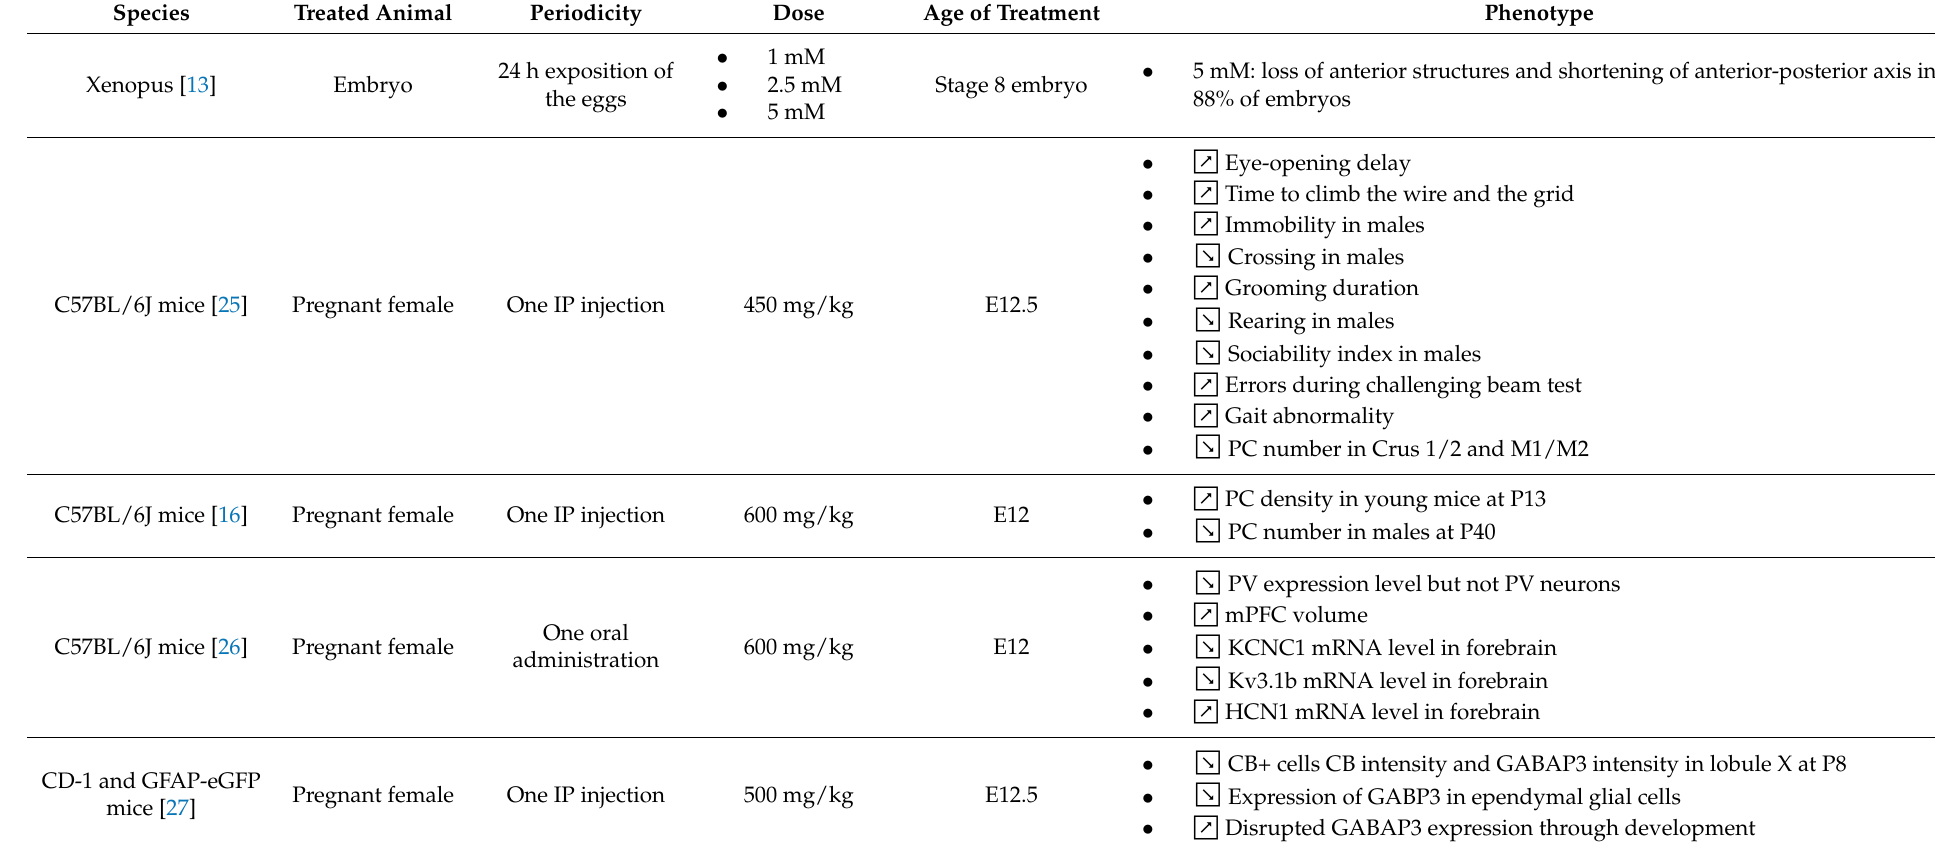
Table 1. Various outcomes in various animal models of valproic acid administration during development in relation with species, dose and age. This table reca- pitulates the different VPA models and their phenotypes. IP: Intraperitoneal injection, USV: Ultrasonic vocalizations, D1R and D2R: D1 dopamine receptor and subunit